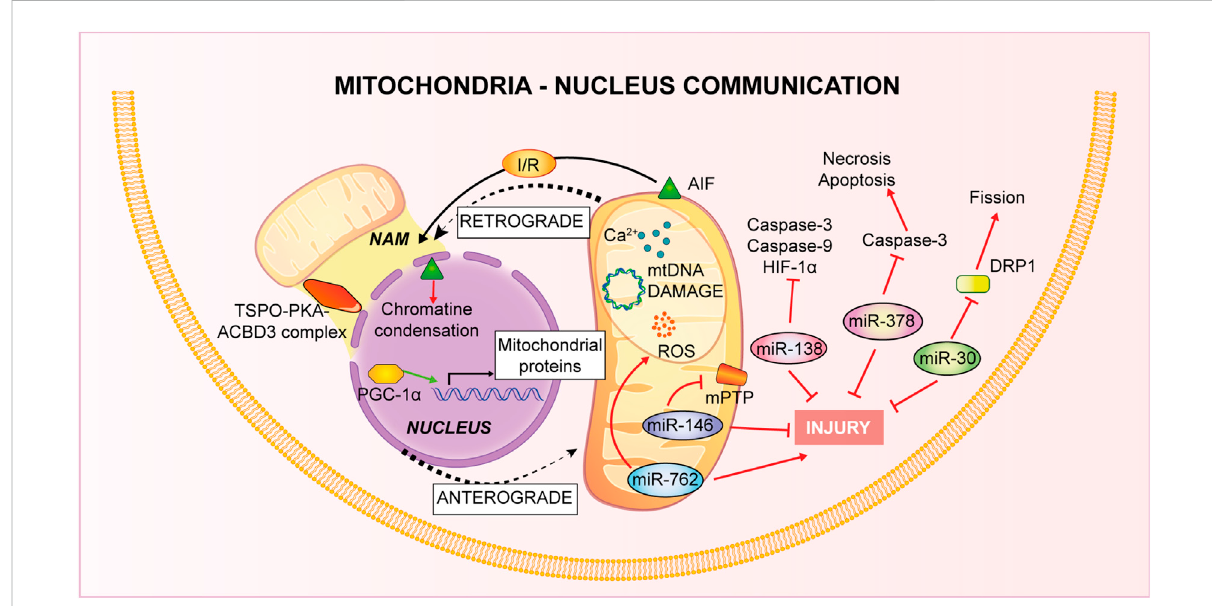
FIGURE 3 Mitochondria-Nucleus communication. Nucleus control of mitochondrial health is named anterograde signaling, through nuclear genes encoding mitochondrial proteins and via miRNAs. Mitochondria, conversely, use a retrograde signaling induced by Ca 2+ -dependent stress, mtDNA damage, metabolic disorders and loss of ψ m